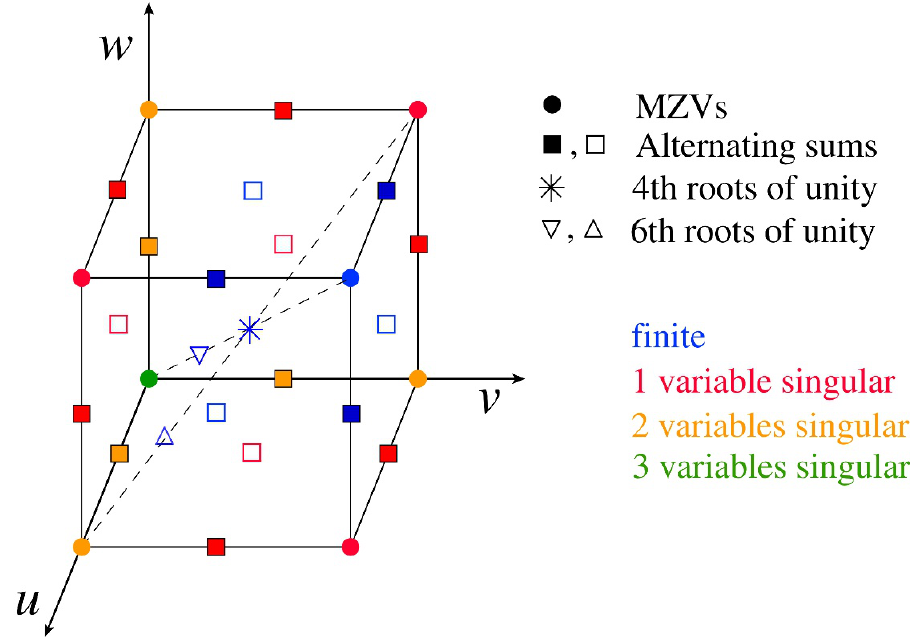
Figure 1 . Points associated with the unit cube in ( u; v; w ) where the functions in H hex evaluate to interesting transcendental numbers associated with polylogarithms with indices that are square, fourth and sixth roots of unity, as indicated by the shape of the symbol. The color of the symbol indicates how many of the three cross ratios are singular (equal to zero) at that point. Table 13 . Dimensions of H hex when restricted to four lines with symbol letters u , 1 (cid:0) u , for weights up to 10. The maximal dimension corresponds to allowing all MZVs and all HPLs with no branch cuts at u = 1. For the last two lines, only the (cid:12)nite parts of the singular limits onto the lines are